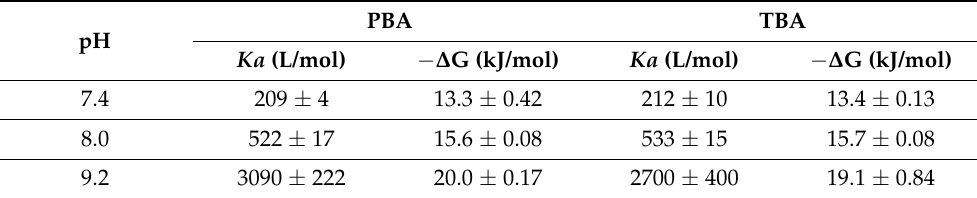
Figure 4. pH dependence of the binding constant of TBA to sorbitol and fructose. Titration conditions: 300 μL of 0.5 mM TBA in the cell and 25 mM of sorbitol in the titration syringe. Table 1. Binding constants and binding energies for the interaction of fructose with TBA and PBA. Measurement conditions: 300 µ L of 1 mM TBA or PBA in the cell, 30 mM of fructose in the titration